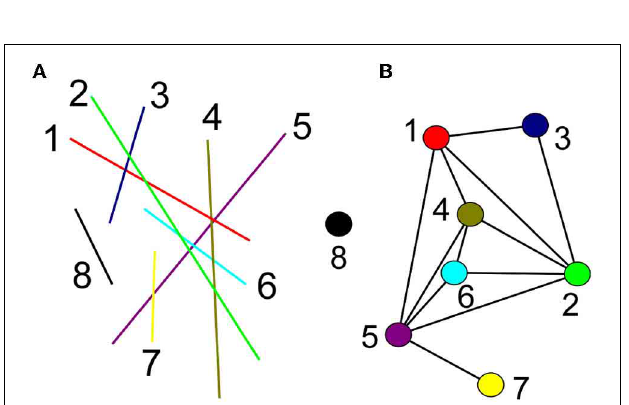
FIGURE 3 | Example of creation of the dual network from a system of fractures. The fractures are followed through intersections, and define nodes in the dual network, nodes made by ridges that meet or cross each other get a link. (A) A small system of fractures and its dual network (B) . The color and numbering of the node in (B) corresponds to the color and the numbering of the fracture in (A) .